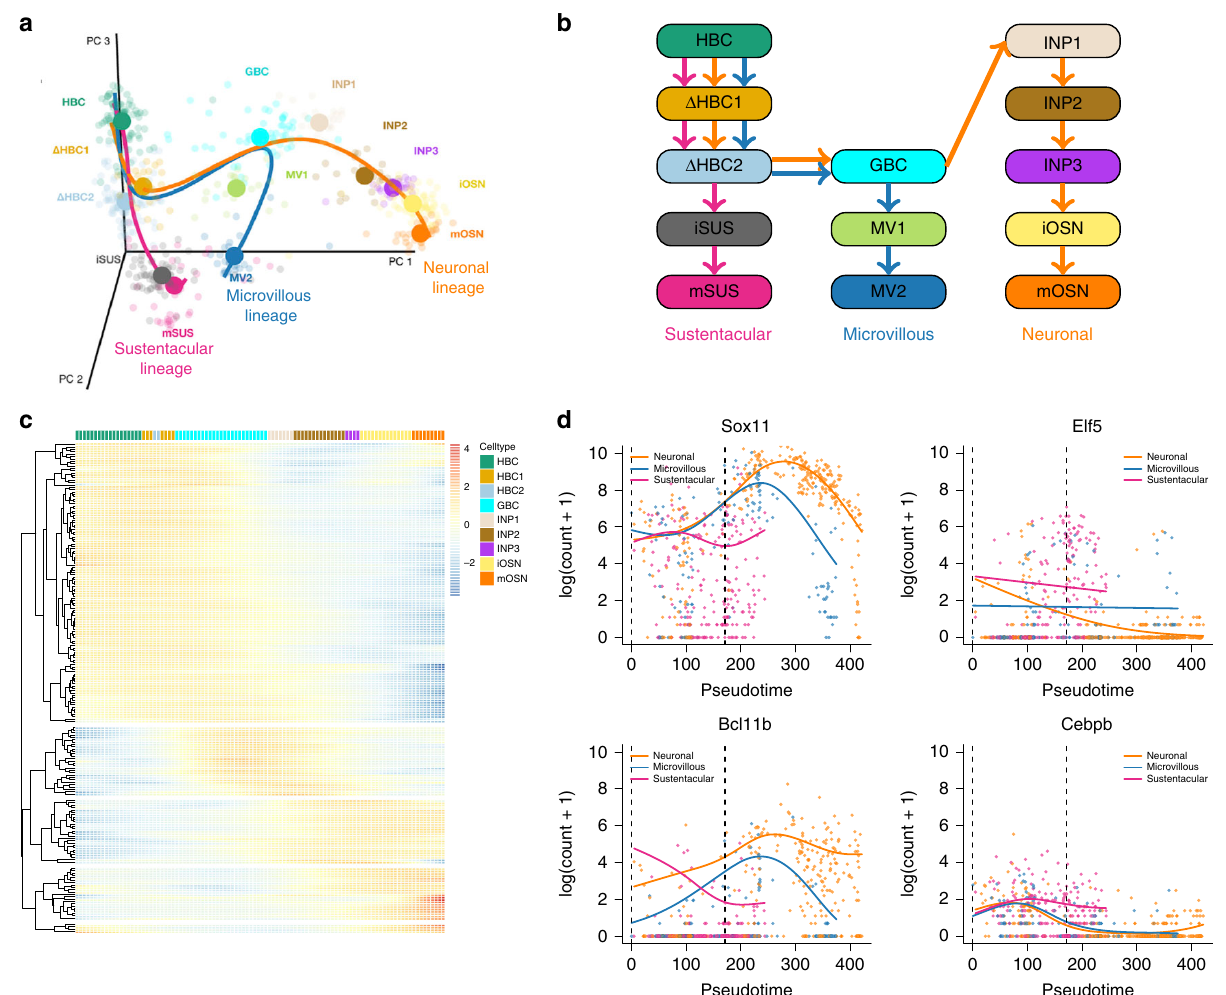
Fig. 6 Mouse olfactory epithelium case study. a Three-dimensional PCA plot of the scRNA-seq data, where cells are colored according to their cluster membership as de fi ned in the original paper (see “ Methods ” ). The simultaneous principal curves for the lineages inferred by slingshot are displayed. This Figure is reprinted from Fletcher et al. 17 with permission from the publisher. b Schematic of the cell types and their ordering along the lineages. c Heatmap for the top 200 genes that are associated with the neuronal lineage, as identi fi ed with the associationTest procedure from tradeSeq. Five clear gene clusters can be identi fi ed, each with a different region of activity during the developmental process. d Four transcription factors discovered by the earlyDETest between the pseudotimes of knots one and three (knots indicated with vertical dashed lines) and that are involved in epithelial cell